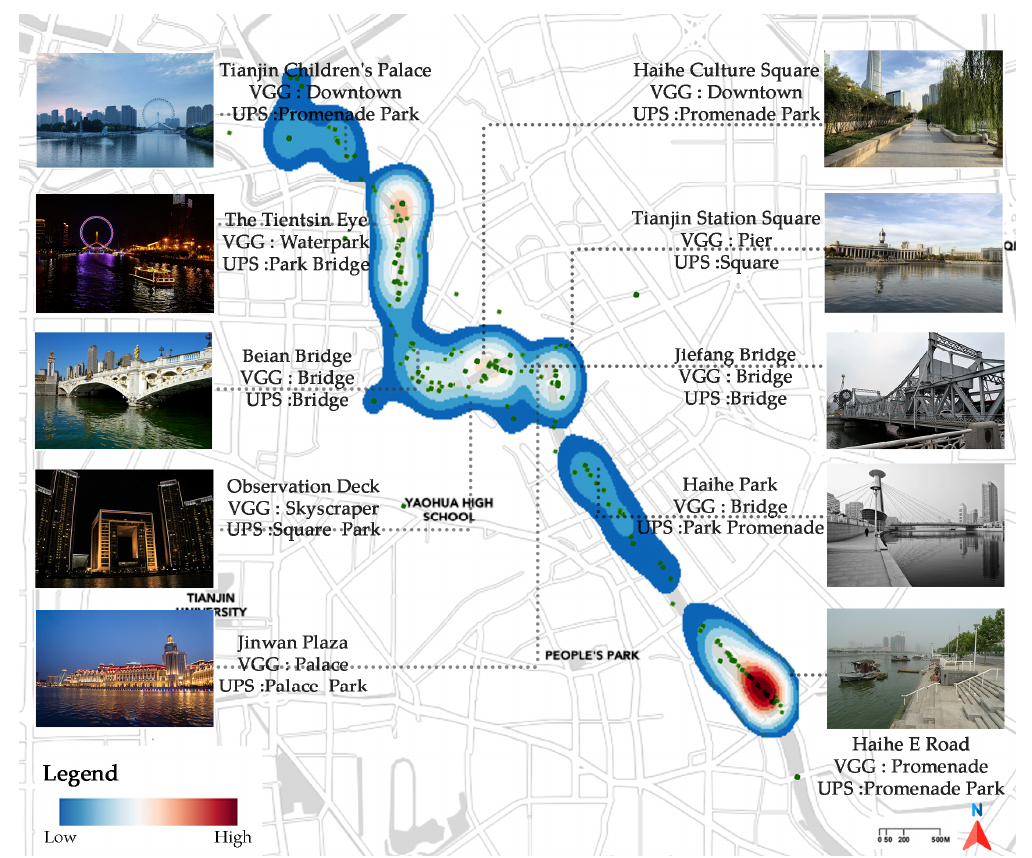
Figure 11. Kernel density result of Haihe River.